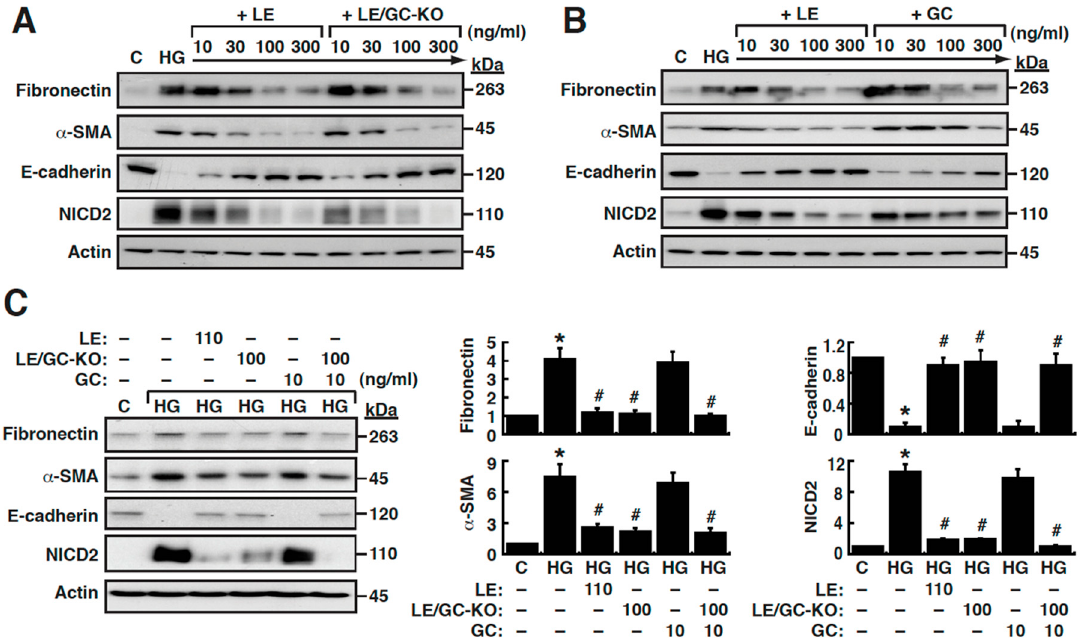
Figure 3. Effects of LE, LE/GC-KO and GC on high glucose (HG)-mediated activation of EMT and Notch2 in NRK-52E cells. ( A ) Comparison of treatment of HG-cultured NRK-52E cells with LE versus LE/GC-KO. Increasing amounts (10 ng/mL, 30 ng/mL, 100 ng/mL and 300 ng/mL) of LE or LE/GC-KO were used to treat HG-cultured NRK-52E cells. At 48 h after treatment, the expression of EMT markers and NICD2 in the treated cells were examined by Western blot analysis. ( B ) Comparison of treatment of HG-cultured NRK-52E cells with LE versus GC. Increasing amounts (10 ng/mL, 30 ng/mL, 100 ng/mL and 300 ng/mL) of LE or GC were used to treat HG-cultured NRK-52E cells. At 48 h after treatment, the expressions of EMT markers and NICD2 in the treated cells were examined by Western blot analysis. ( C ) Changes in the expression levels of EMT markers and NICD2 in HG-cultured NRK-52E cells treated with LE (110 ng/mL), LE/GC-KO (100 ng/mL), GC (10 ng/mL), or the combination of LE/GC-KO (100 ng/mL) and GC (10 ng/mL). At 48 h after treatment, cells were harvested for Western blotting. * p < 0.05 versus normal controls, # p < 0.05 versus untreated HG-cultured cells ( n = 3).